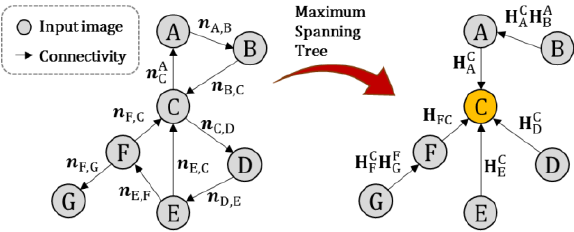
Figure 2. Determination of global transformation from relative transformation.